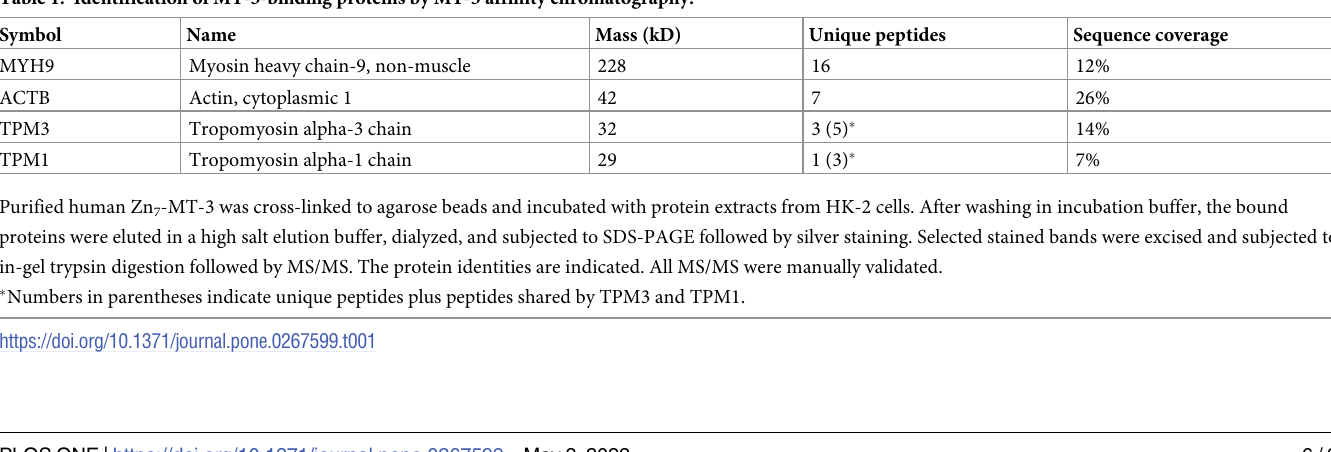
Table 1. Identification of MT-3-binding proteins by MT-3 affinity